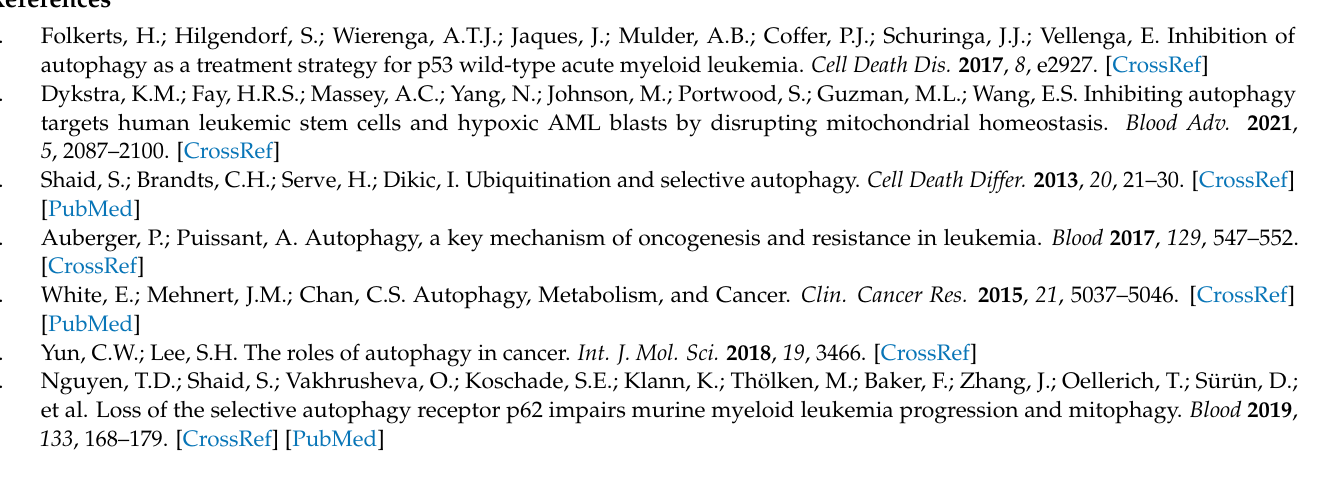
Figure S1: CRISPR/Cas9 proliferation screen with autophagy library. Figure S2: Autophagy flux, LC3 lipidation, ATG7 and ATG4 expression, and autophagosome formation in ATG3-depleted AML cells. Figure S3: Colony formation, cell cycle, and apoptosis analysis upon loss of ATG3. Figure S4: Flow cytometry images of mitochondrial membrane potential, and mitochondrial mass, and western blot quantification of COXIV. Figure S5: Quantification of key parameters of mitochondrial function. Figure S6: Lactate production, ECAR measurements, and glutamine deprivation in ATG3-depleted AML cells. Figure S7: Full length membrane views of western blots. Table S1: Significant dropout genes from CRISPR/Cas9 autophagy screen in THP-1 and MV4-11